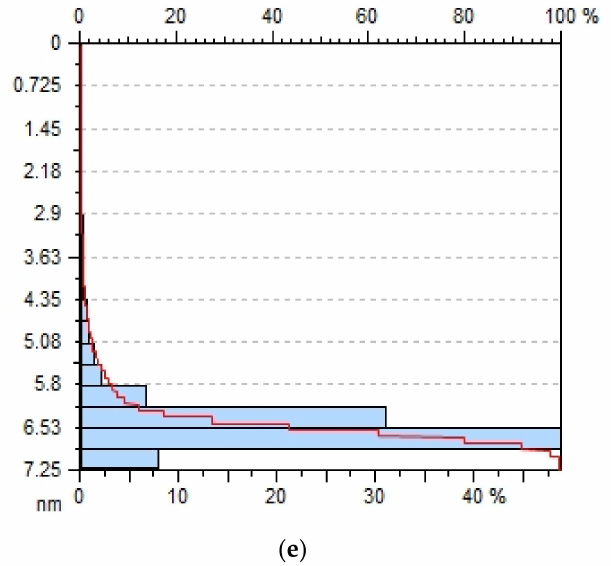
Figure 6. AFM images of prepared silver nanoparticles, ( a , b ) 2D images, ( c , d ) 3D zoomed images of nanoparticles along Z-axis, and ( e ) size distribution throughout the solution.